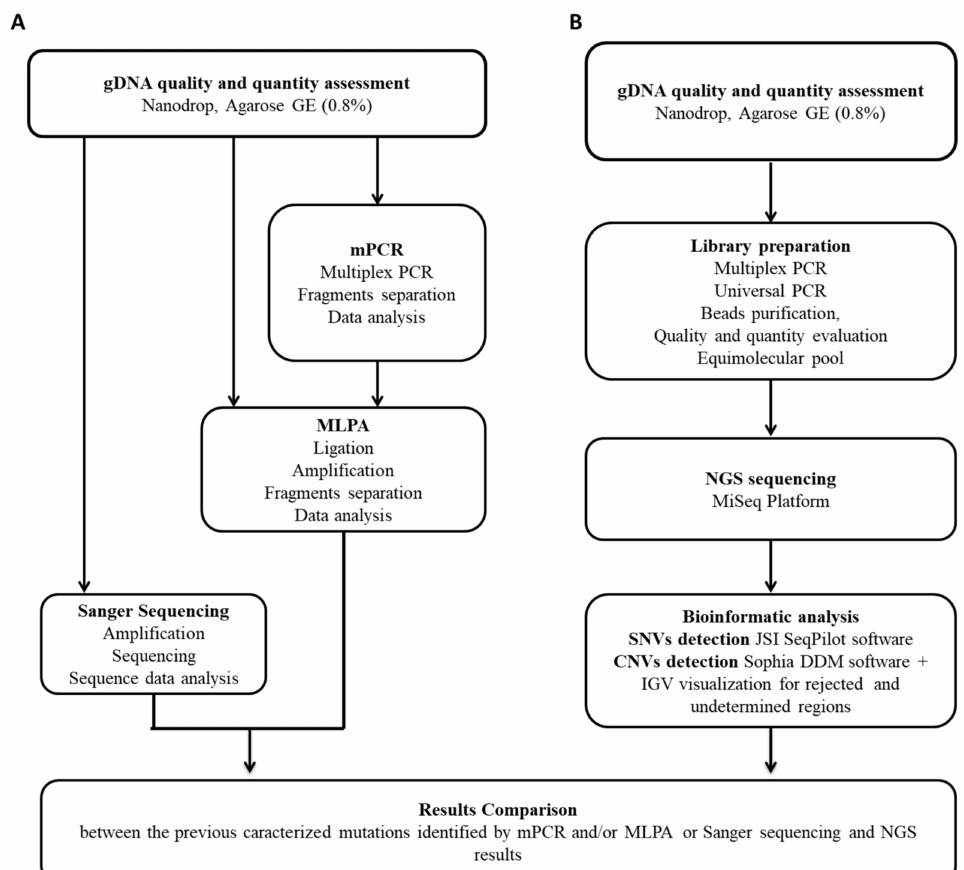
Figure 1. Summary of the analytic workflow. After genomic DNA quality and quantity assessment, each sample has been analyzed according to traditional molecular techniques ( A ) and NGS ( B ). In particular, MLPA and/or Sanger sequencing were carried out to detect DMD pathogenic mutations ( A ). The same samples were analyzed blindly by NGS ( B ). DNA libraries were prepared with an amplicon-based protocol for each study subject. Obtained libraries (corresponding to 40